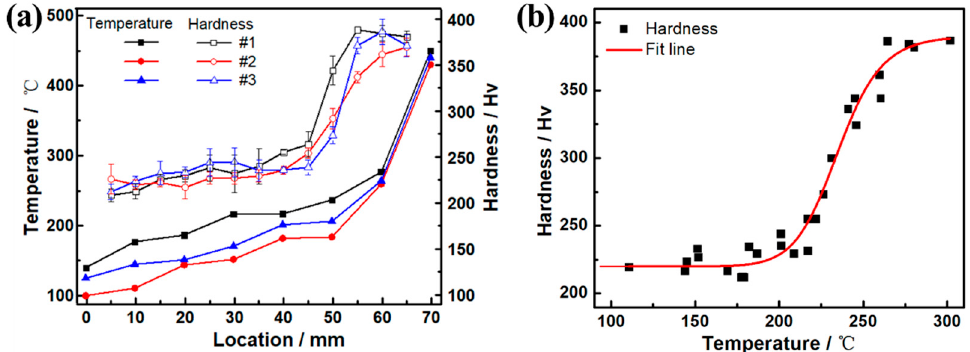
Figure 4. ( a ) Changes of Vickers hardness and temperature with the location along the sample length; ( b ) changes of Vickers hardness with the temperature in the samples. ( b ) changes of Vickers hardness with the temperature in the